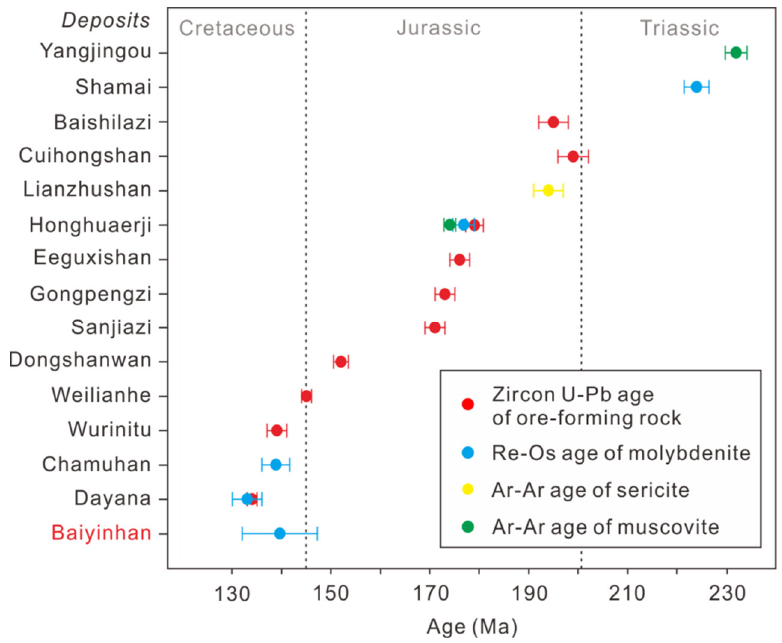
Figure 10. Ages of W-(Mo) deposits in NE China (data from [11,23,81–86] and this paper).